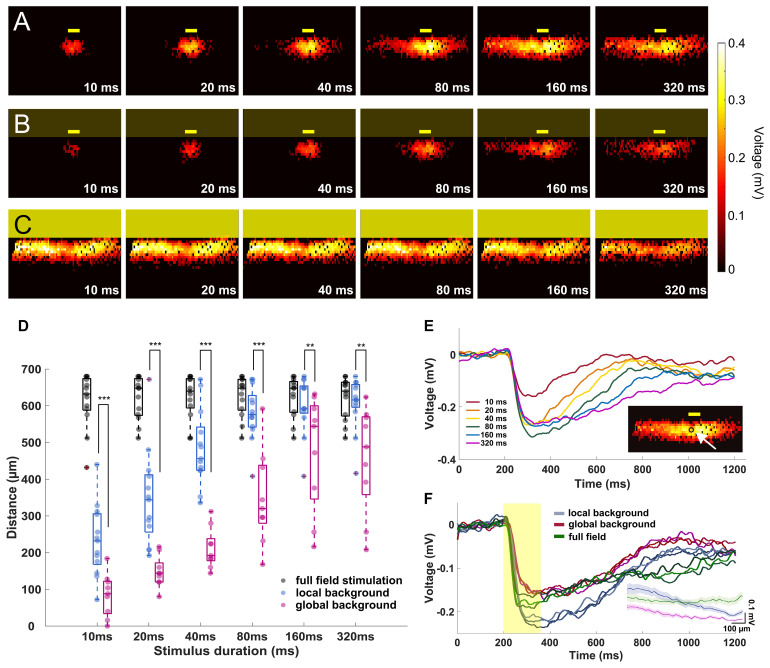
The signal propagation distance increases with stimulation duration. (A–C) Heat maps showing active electrodes for different stimulus durations. The stimulus durations range between 10 ms (left) and 320 ms (right). The heat map color represents the amplitude of the extracellular peak voltage. Yellow boxes mark the light stimulus. Size of the light stimulus: 100 μm wide × 30 μm high. (A) Local background stimulus. (B) Global background stimulus. (C) Full field stimulus. (D) Evaluation of the signal propagation distance for different light stimulus conditions. The distance increases with stimulation duration for both local (n = 13 slices) and global background stimuli (n = 9 slices). For all stimulus durations, the signal propagated significantly further under local background (no surround inhibition) than for global background (with surround inhibition). Significance tests were performed with the Wilcoxon rank-sum test. **P < 0.01 and ***P < 0.001). Under full-field stimulation (n = 13 slices, black symbols), there was no difference between the stimulus durations. (E) Extracellular voltages recorded from an electrode locates downstream of the local stimulus with local background from different stimulus durations. The stimulation duration does not affect the voltage amplitude but only the duration of the responses except for 10 ms. In the insert, the arrow points to the electrode from which the signals are shown. (F) Overlaid extracellular voltages recorded from three electrodes downstream of the stimulus area with local background (blue lines), global background (red lines), and full-field stimuli (green). The yellow box represents the 160-ms light pulse. The voltage decreased when stimulation was performed on global background or using full-field stimulus, suggesting the recruitment of an inhibitory input. The insert shows the average peak amplitude versus distance from the stimulus center for the local background stimuli, global background stimuli, and full-field stimuli.